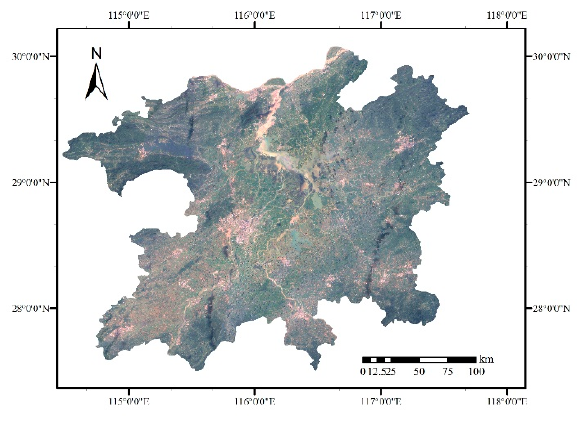
Figure 2. Study area.